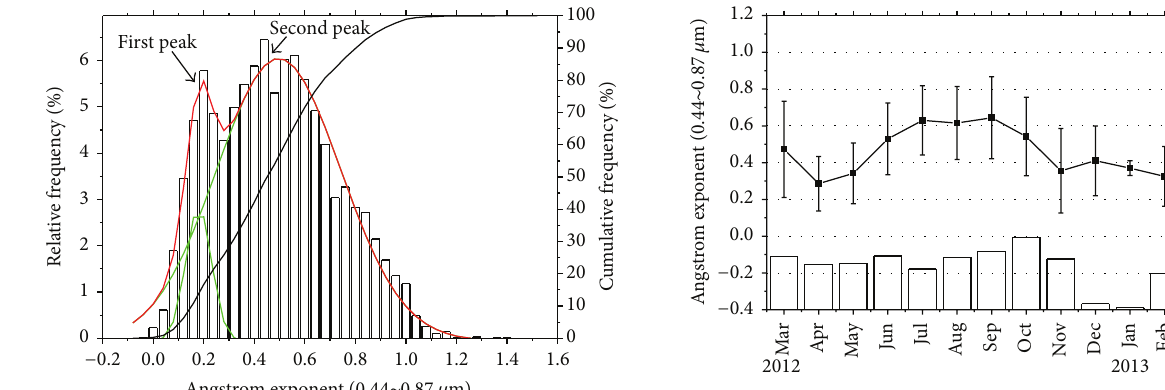
Figure 4: The frequency distribution of ˚Angstr¨om exponents (0.44 ∼ 0.87 𝜇 m) in the form of relative histogram and accumulated frequency.